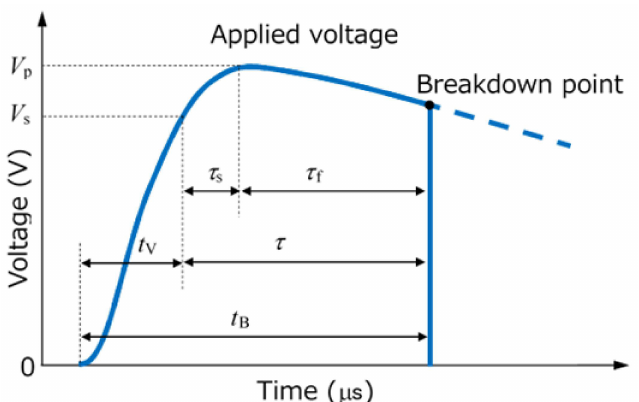
Figure 4. Typical breakdown and time lag under impulse voltage. Here, V p and V s are peak voltage and minimum breakdown voltage, respectively, and t B and t v are the breakdown time and the time when the charge voltage exceeds V s , respectively. Moreover, τ , τ s , and τ f are the delay time, the statistical time, and formative time, respectively